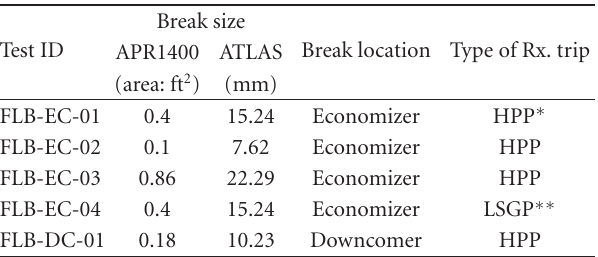
Table 6: Test matrix for FLB